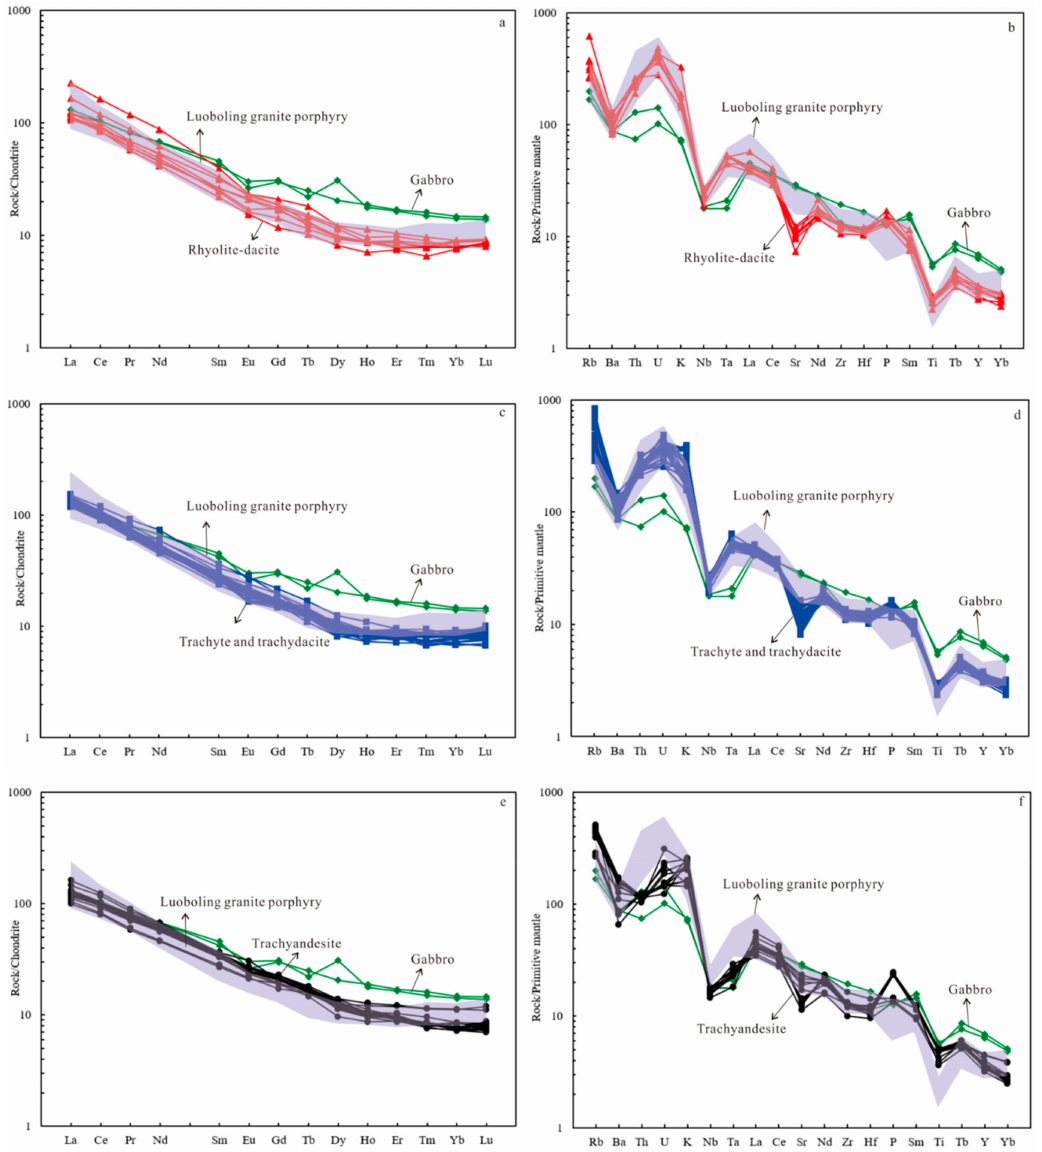
Figure 8. Whole rock Chondrite-normalized rare-earth element (REE) patterns and primitive- mantle-normalized spidergrams for volcanic rocks of the Shimaoshan Group. ( a , c , e ) The REE patterns of rhyolite-dacite, trachyte and trachydacite, trachyandesite; ( b , d , f ) The spidergrams of rhyolite-dacite, trachyte and trachydacite, trachyandesite. Normalized values are from [54]. The shaded regions represent the Luoboling granite porphyry, and the green lines represent Cretaceous gabbro from the coastal area of Fujian. Data for the Luoboling granite porphyry are from [32,35,51]; data for gabbro are from